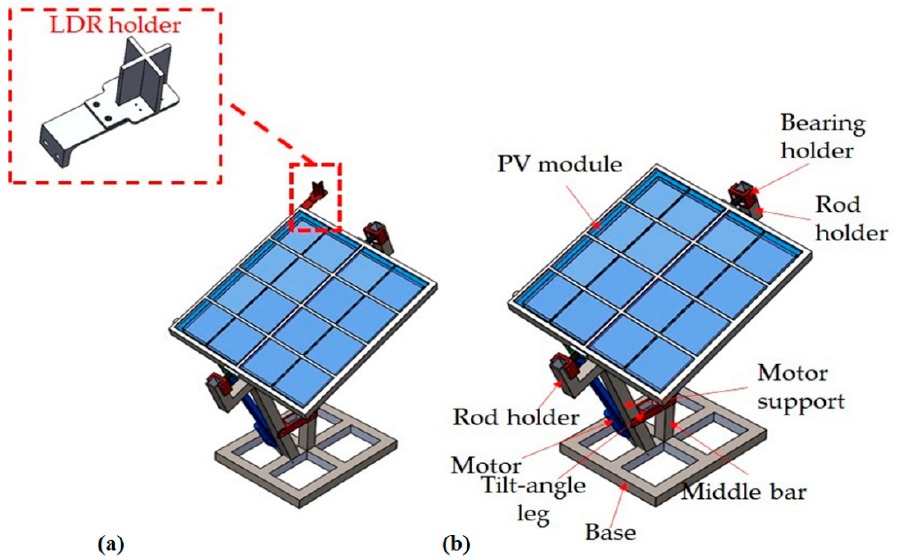
Figure 1. CAD model for ( a ) sensor-based SAST and ( b ) azimuth-based SAST.